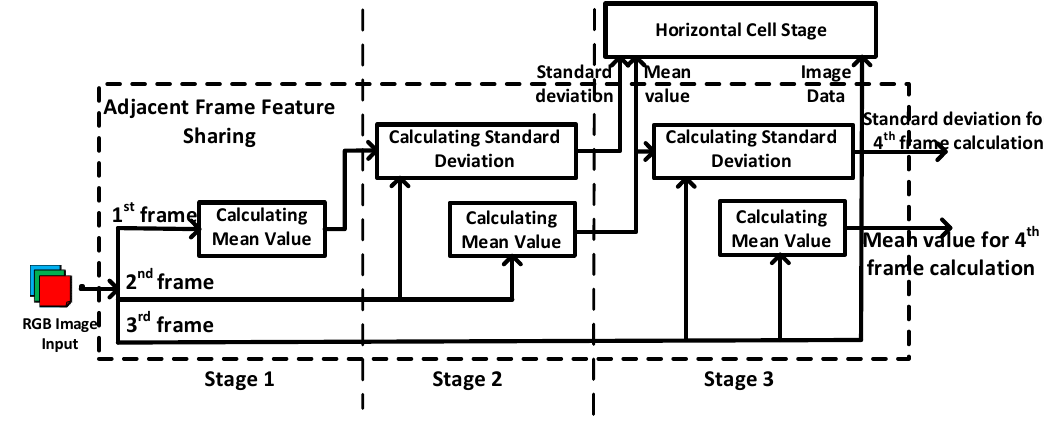
Figure 4. Adjacent frame feature sharing.